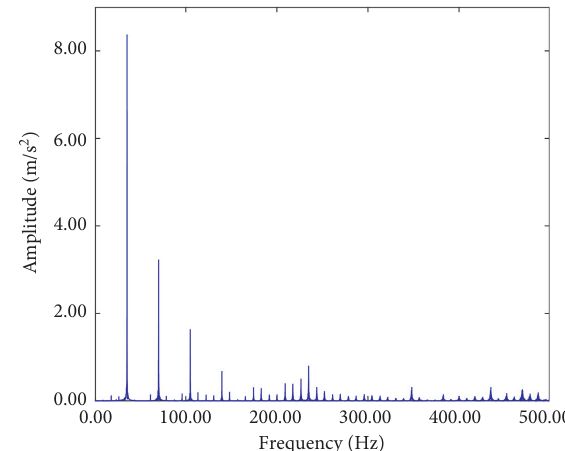
Figure 6: Experimental frequency-domain dynamic response characteristic curves of measuring point 1 in the vertical direction.